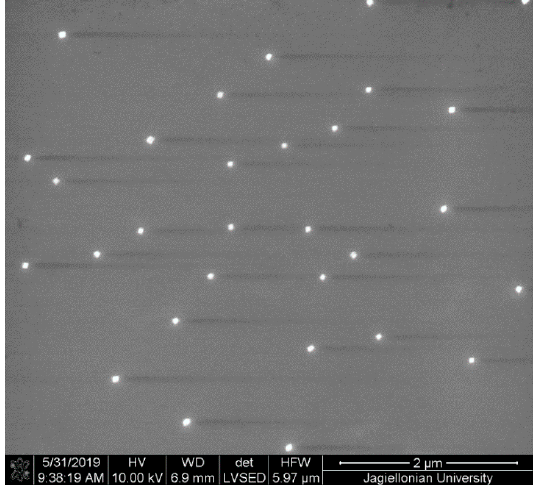
Figure 4. Representative SEM image of CaCO 3 NPs incorporated in POEGMA-grafted brush coatings.